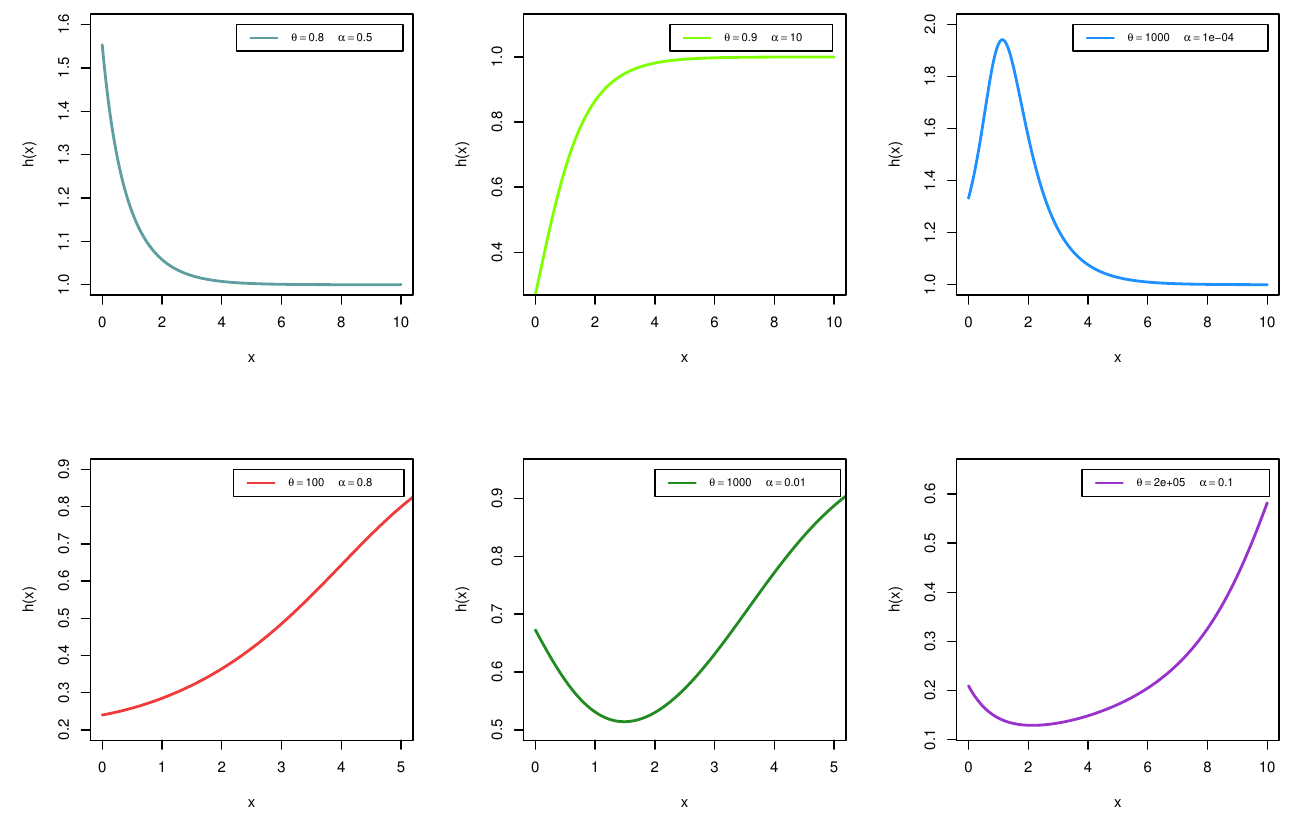
Figure 2. Different plots of the HRF of the LTAPEx distribution for various values of θ and α with β =